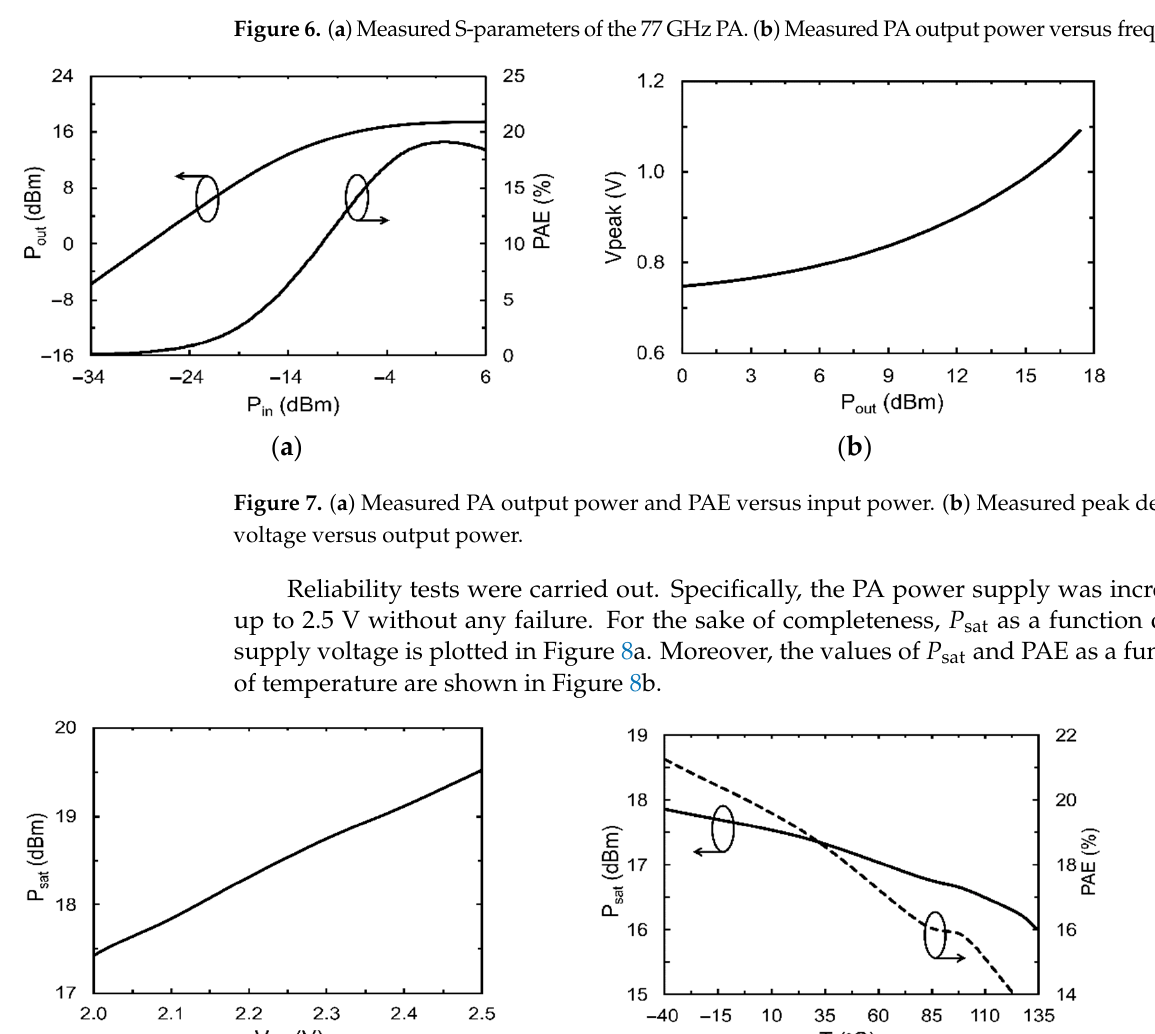
Figure 8. ( a ) Measured P sat versus supply voltage. ( b ) Measured P sat and PAE versus temperature.